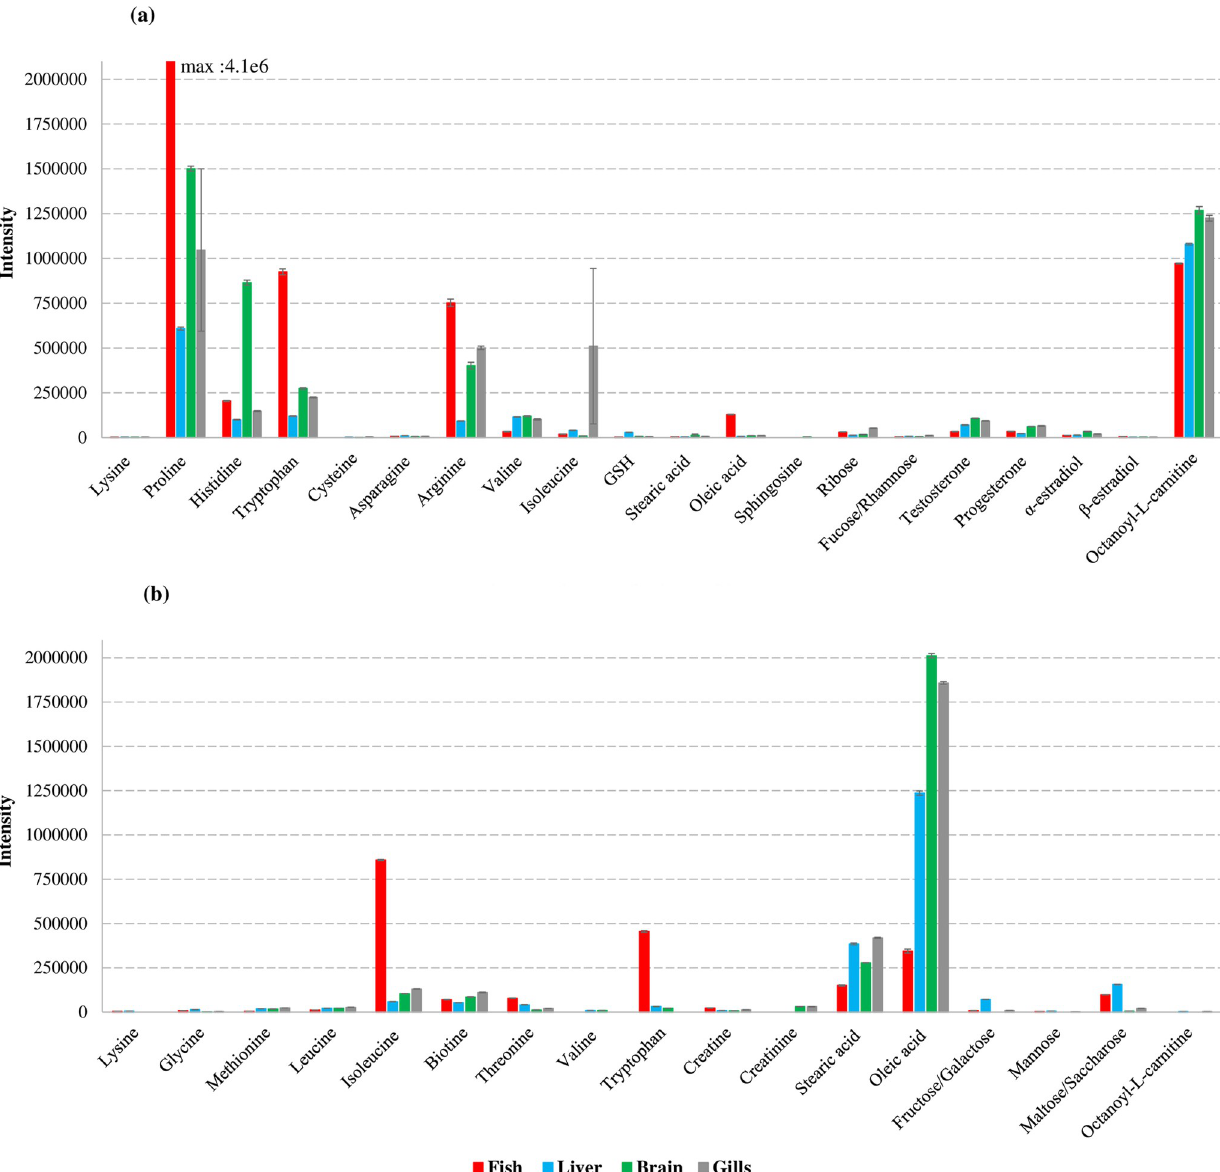
Fig 7. Intensities of targeted metabolites detected in fish, liver, brain and gills, analyzed in (a) RPLC(ESI+) and (b) HILIC(ESI-).